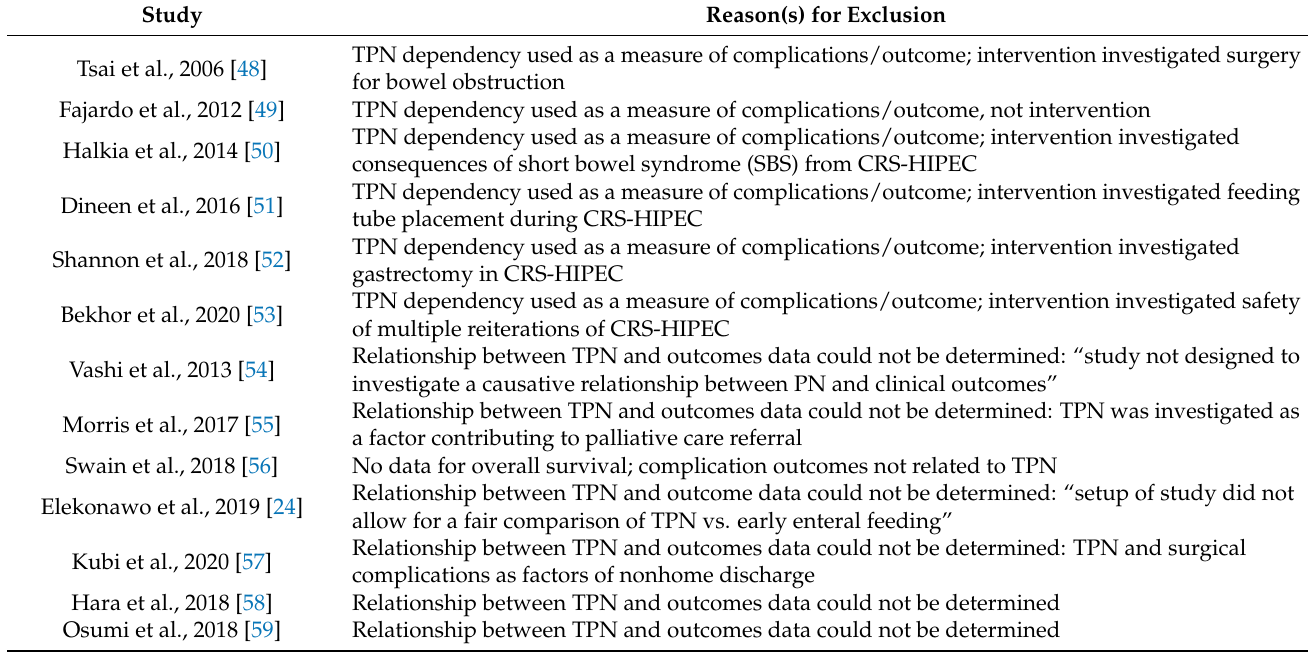
Table 3. Studies excluded from full-text